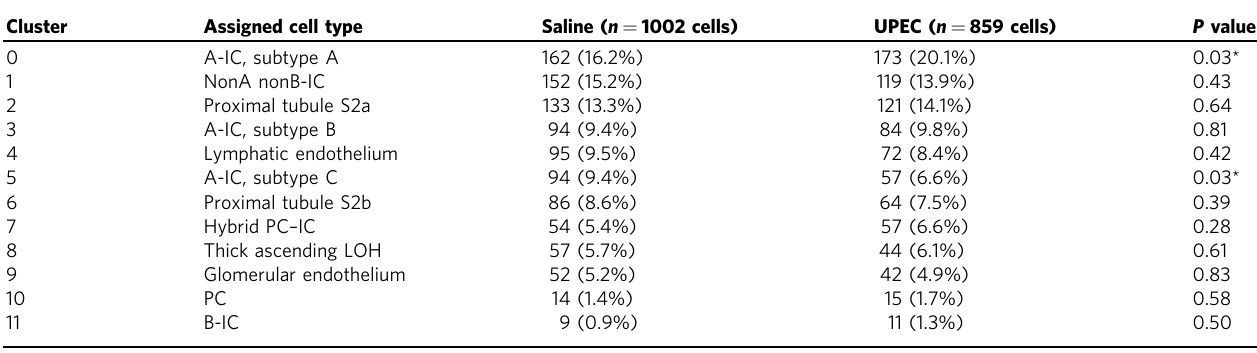
Fig. 4 Murine-collecting duct cell-type marker expression patterns are generally conserved in human collecting duct cells. IC markers include the D2, C2, B1, and G3 subunits of V-ATPase ( ATP6V0D2 , ATP6V1C2 , ATP6V1B1 , and ATP6V1G3 respectively), carbonic anhydrase 12 ( CA12 ), and forkhead box protein I1 ( FOXI1 ). A-IC markers include aquaporin 6 ( AQP6 ), SLC4A1 , adhesion G protein-coupled receptor F5 ( ADGRF5 ), and solute carrier family 26 member 7 ( SLC26A7 ). B-IC markers include insulin receptor-related receptor ( INSRR ), SLC26A4 , and solute carrier family 4 member 9 ( SLC4A9 ). PC markers include AQP2 , calbindin 1 ( CALB1 ), FXYD domain containing ion transport regulator 4 ( FXYD4 ), and SCCN1G . Homeobox D10 ( HOXD10 ) is a nephron lineage marker. A dot plot of murine-collecting duct cell-type marker gene expression in human kidney cells is presented. Collecting duct cell types are shaded. Murine markers for ICs and A-ICs are expressed in all human ICs of the same subtypes. The murine B-IC marker SLC4A9 is expressed in human A-IC subtypes A and B along with human B-ICs. Murine PC marker genes are primarily limited to PCs and hybrid PC – ICs in humans, except for FXYD4 , which is also expressed in some A-IC subtypes. The majority of human collecting duct cells in this analysis were HOXD10 negative, indicating ureteric origin. PCs and PCs – ICs were the cells that had the highest percentage of HOXD10 positivity indicating derivation from the distal nephron. However, nephron-derived cells still represented a minority of PCs and PCs – ICs. Saline-exposed cell results are presented. Table 1 Differential cell type frequency in UPEC vs. saline exposed